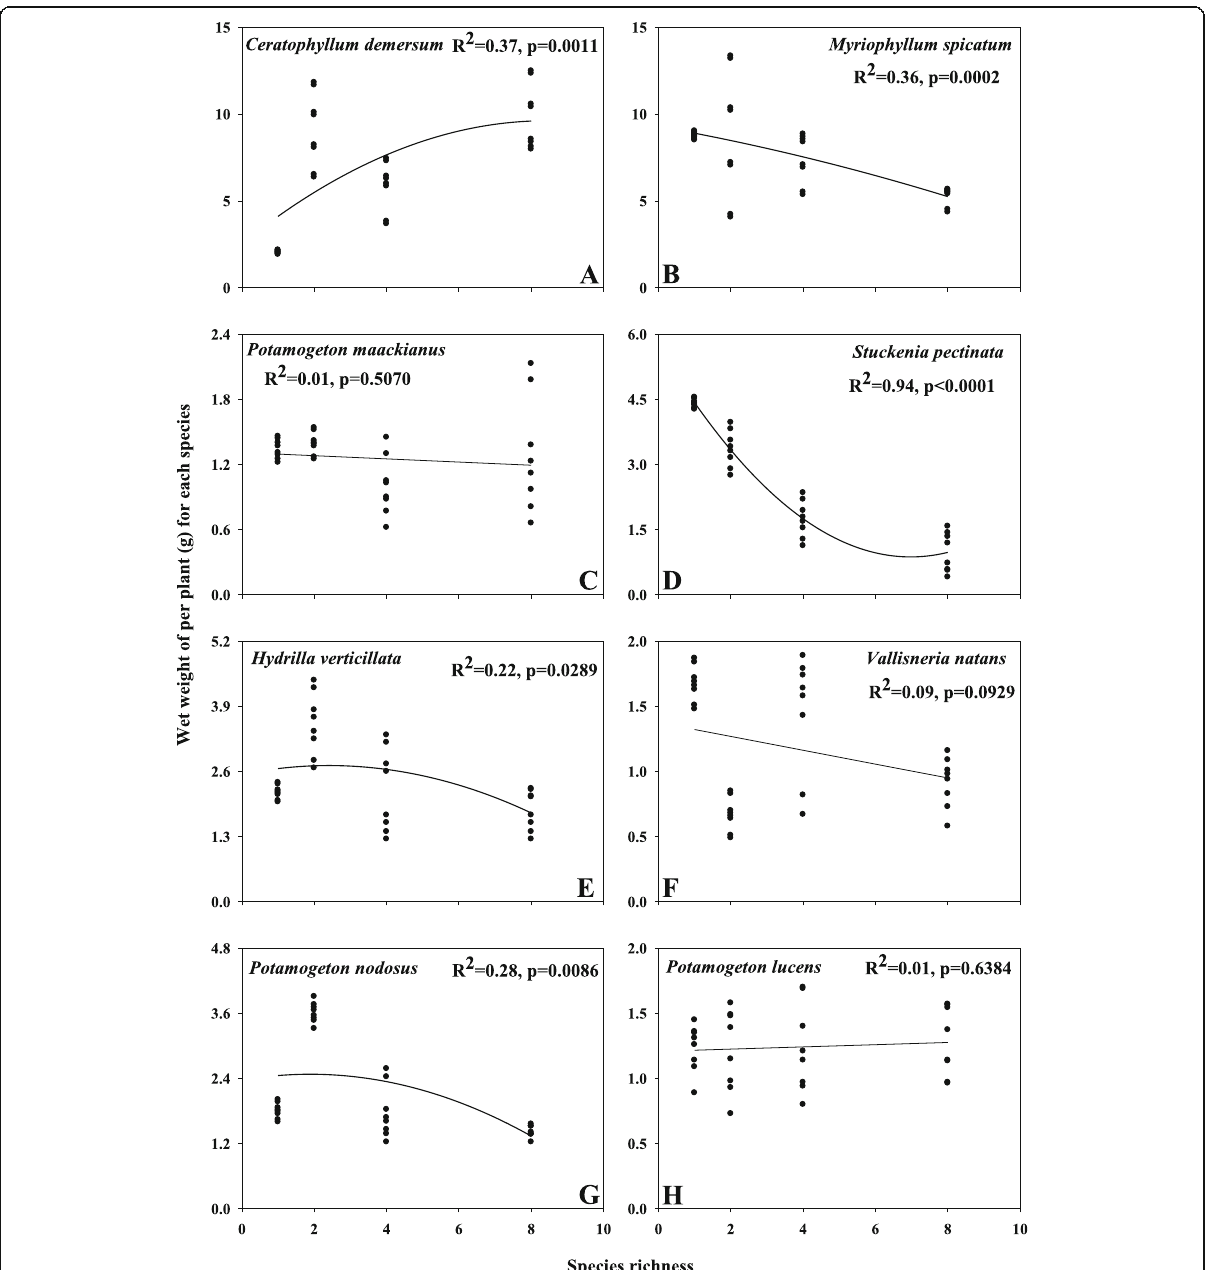
Fig. 2 The species level plant masses of individual species along an aquatic plant biodiversity gradient in Lake Erhai. Eight common native submerged species were selected in this experiment, see Materials and